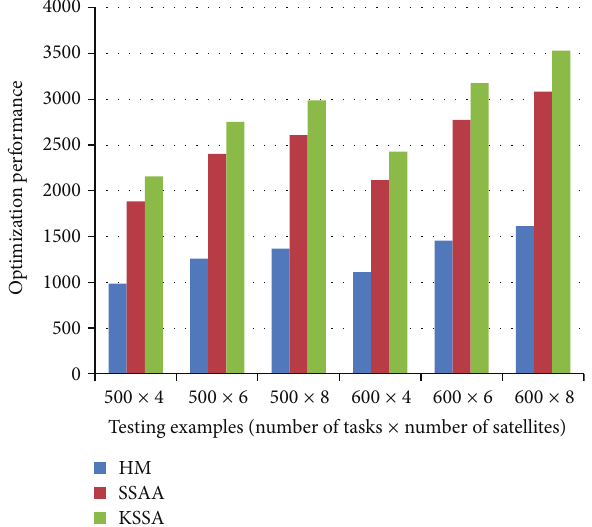
Figure7:Experimentalresultsinoptimizationperformanceoflarge scale testing